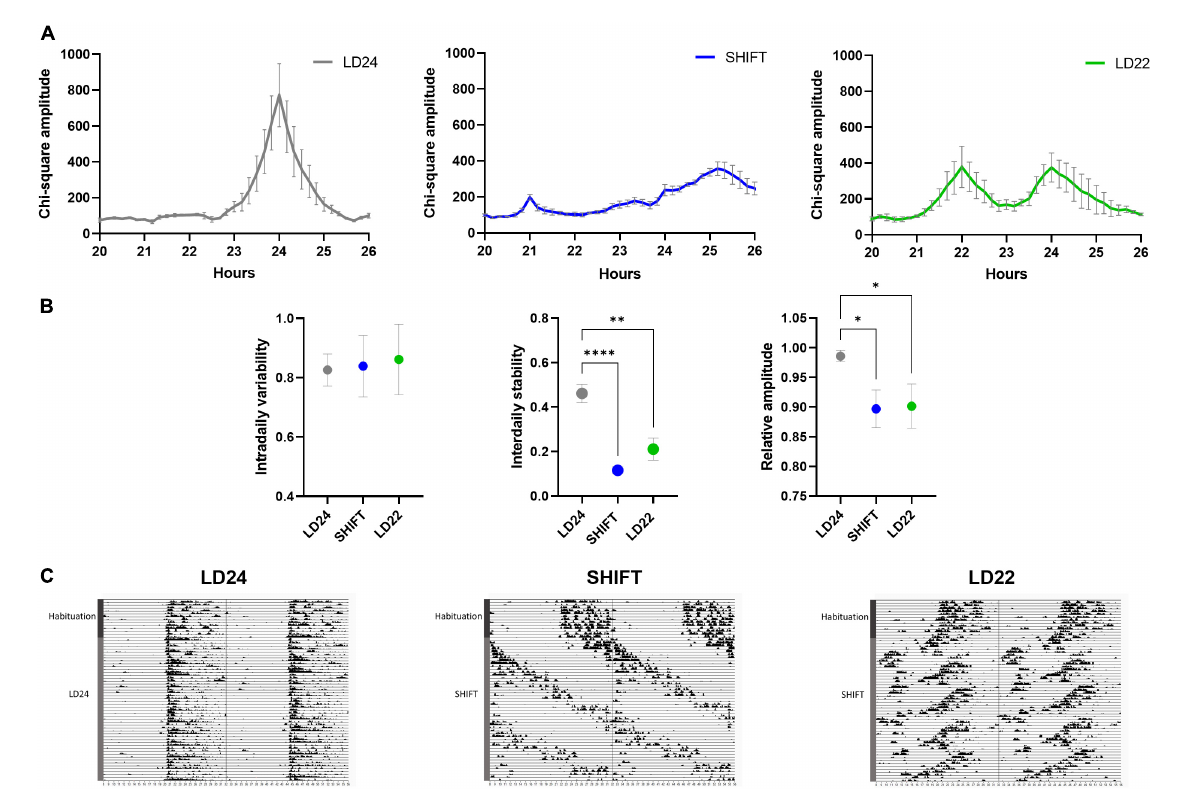
FIGURE2 Locomotor activity under altered light-dark (LD) schedules. (A) Comparison of periodograms and actograms under LD24, SHIFT, and LD22 conditions and (B) determination of intradaily variability (IV), interdaily stability (IS), and relative amplitude (RA) over a period of 14 days. One-way ANOVA, Dunnett’s multiple comparisons test: ∗∗∗∗ p < 0.0001, ∗∗ p < 0.01, ∗ p < 0.05; ± SEM; n = 4–12. (C) Representative circadian actograms for one animal for each LD paradigm (50 days). Time of day is double-plotted along the x-axis, and successive days are arranged from top to bottom along the